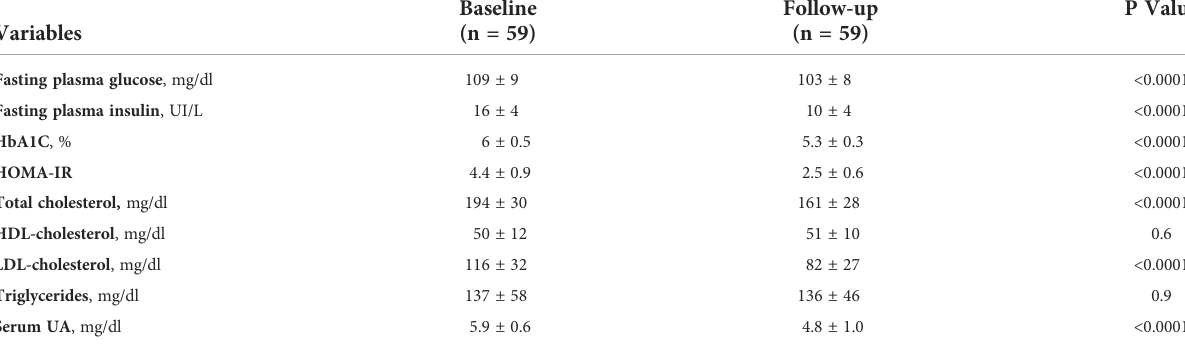
TABLE 3 Metabolic characteristics at baseline and after 24 weeks of therapy with sac/val.